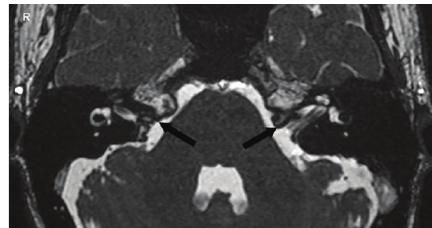
Figure 4: MRI scan of inner ear with axial section showing bilateral hypoplastic internal auditory canals.